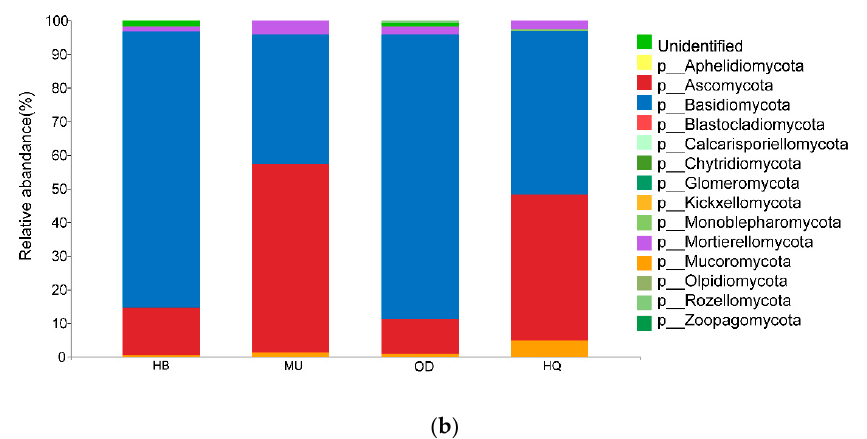
Figure 3. Relative abundances of bacterial ( a ) and fungal ( b ) phyla in each P. sylvestris stand across four sandy lands.